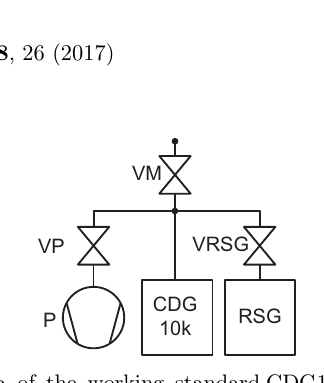
Fig. 7. Set-up of the working standard.CDG10k: capacitance diaphragm gauges MKS type 690 with an effective full scale of 10kPa; RSG: resonant silicon gauge Druck type DPI142 (3.5 – 130kPa); P: vacuum pump; VM: isolation valve of the working standard; VRSG: isolation valve of the RSG; VP: isolation valve of the